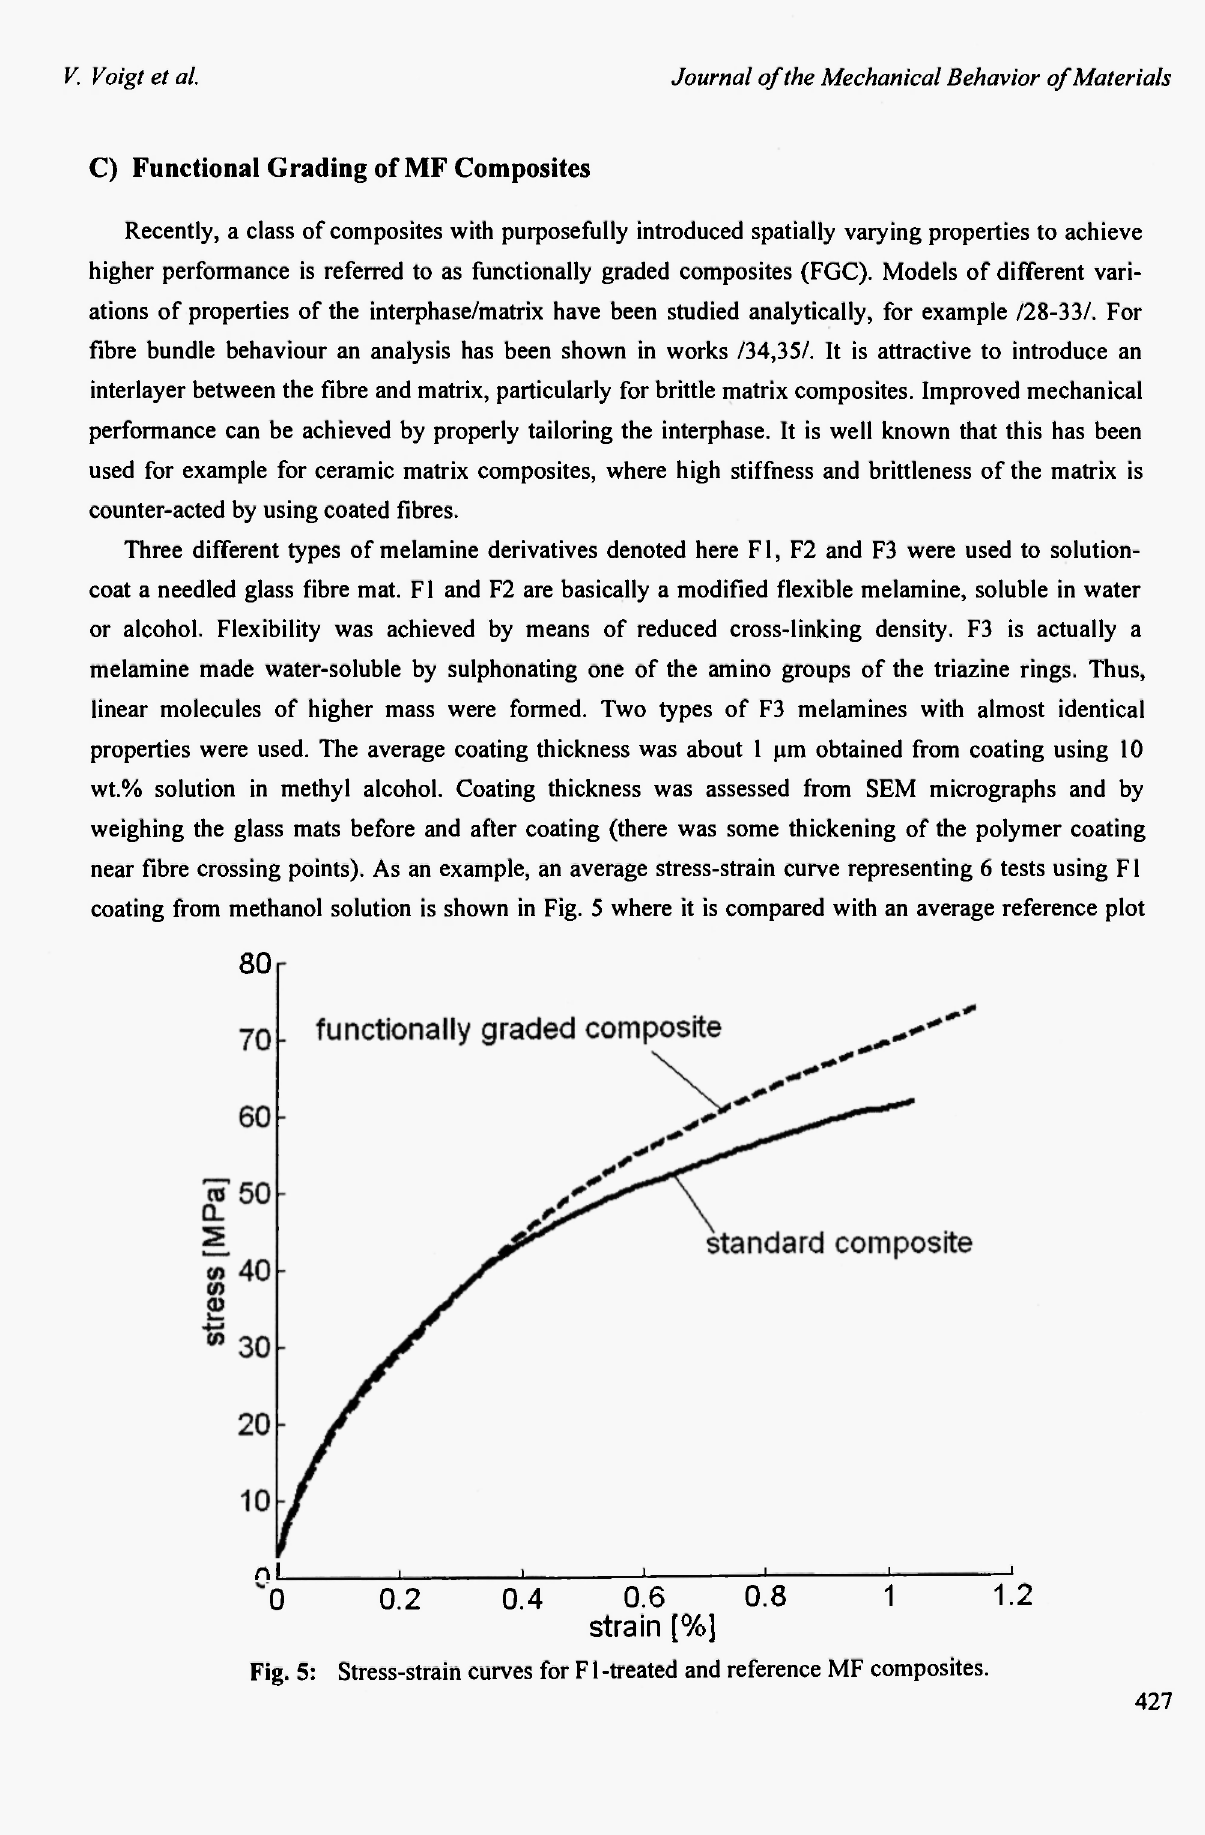
Fig. 5: Stress-strain curves for F1 -treated and reference MF